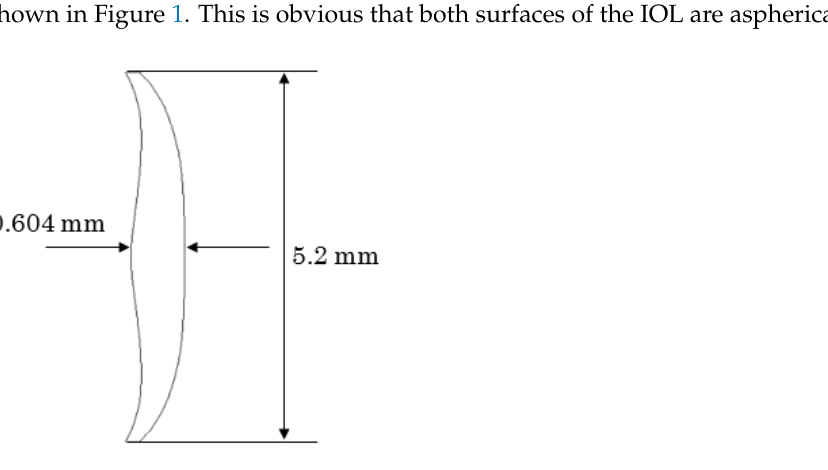
Figure 1. The cross-section profile of the effective optical zone of the optimized IOL. Table 3. The designed IOL surface